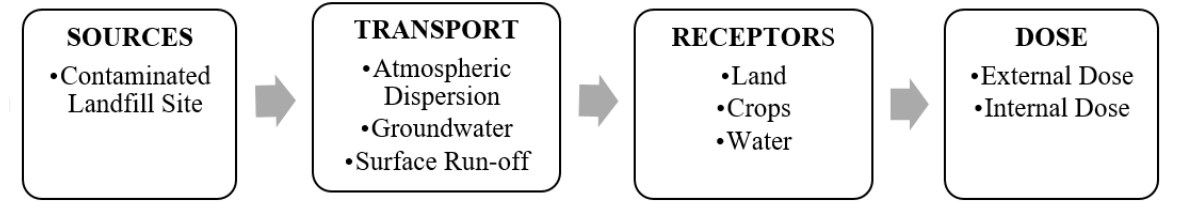
Figure 3. Main libraries in NORM and LegacY Site Assessment.